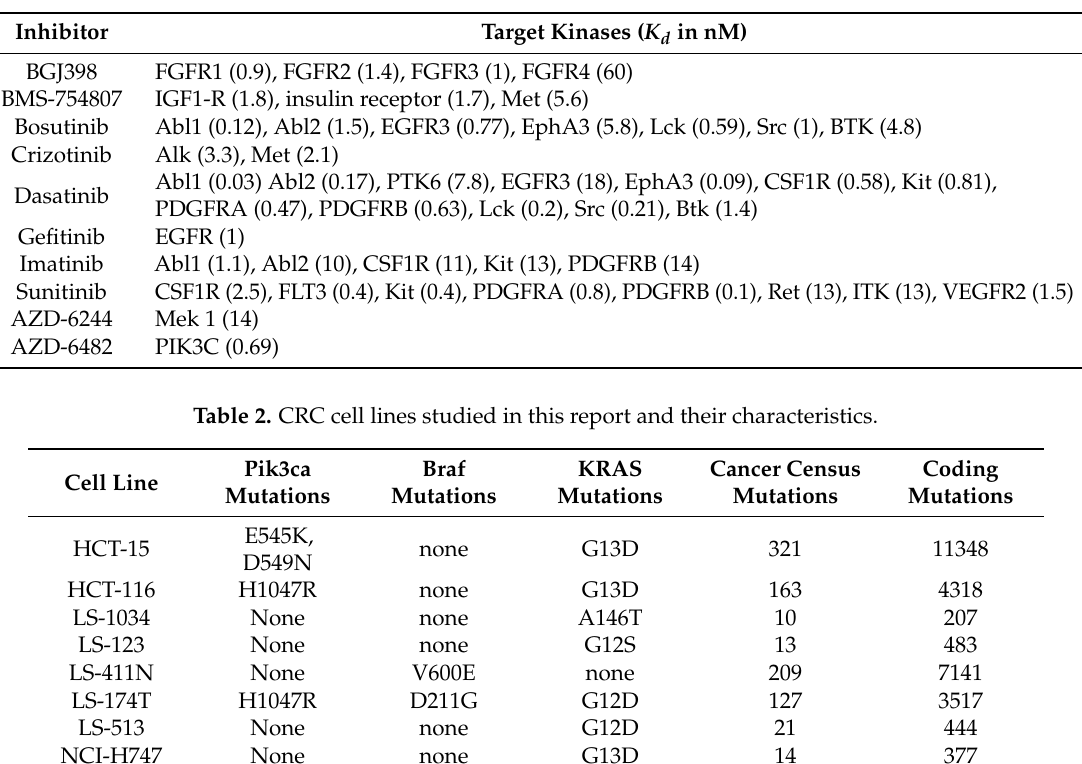
Table 1. Kinase inhibitors used in this study and the target cancer census protein tyrosine kinase they inhibit. The inhibitors below, with the exception of BGJ398 and BMS-754807, have been tested against majority of the kinases in the kinome (http://lincs.hms.harvard.edu/kinomescan/). The target cancer census kinases with K d values below 20 nM are listed as the number in the parenthesis in nM. BGJ398 and BMS-754807 have not been tested against the kinome. The data for BGJ398 and BMS-754807 are taken from references 23 and 21, respectively. The IC 50 of AZD-6244 against MEK 1 is taken from reference 24.